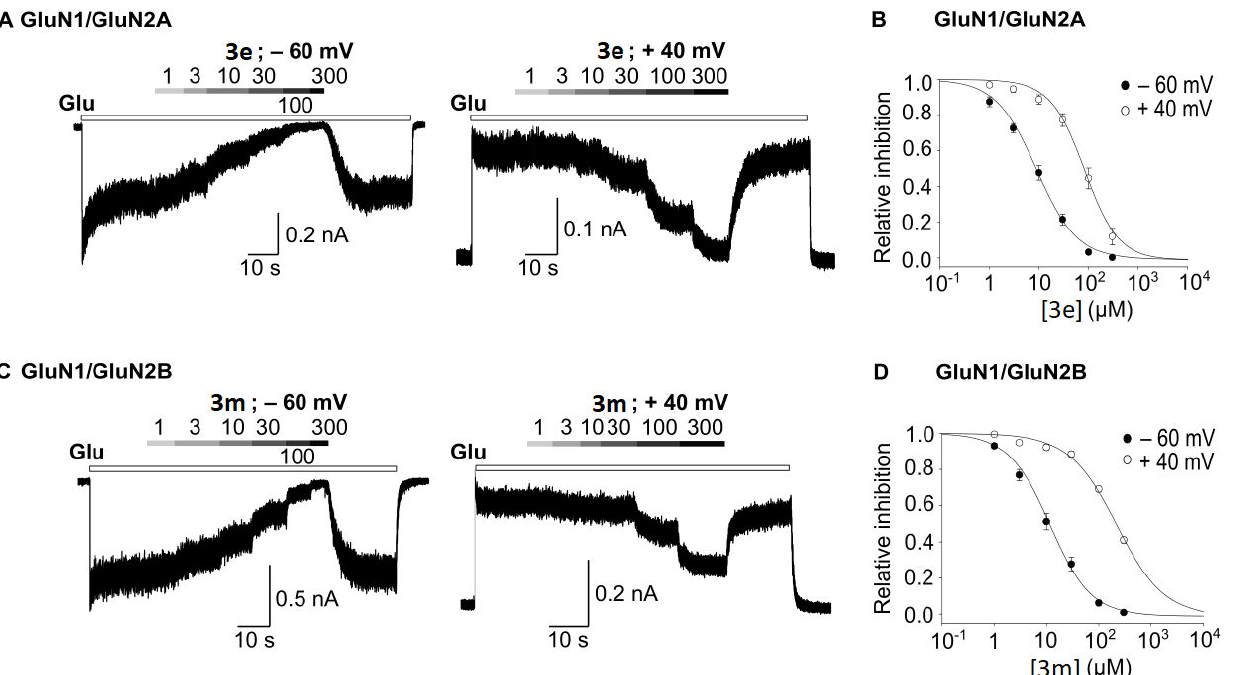
Figure 6. The most potent inhibitory compounds 3e and 3m acting at the GluN1/GluN2A and GluN1/GluN2B receptors. ( A ) Whole-cell representative currents of the GluN1/GluN2A receptors showing the inhibitory effects of 3e (1–300 µ M) at membrane potentials − 60 mV and +40 mV. ( C ) Representative currents of the GluN1/GluN2B receptors inhibited by 3m (1–300 µ M) at membrane potentials − 60 mV and +40 mV. ( B , D ) Dose-response inhibitory curves at two membrane potentials ( − 60 and +40 mV) at the GluN1/GluN2A receptors for 3e ( B ) and at the GluN1/GluN2B receptors for 3m ( D ). The inhibition dose-response curves were fitted by Equation (1) (see Section 2.5.2); the resulting values are shown in Table 4. Table 5. The effects of the tested compounds on the CHO-K1 cell viability.